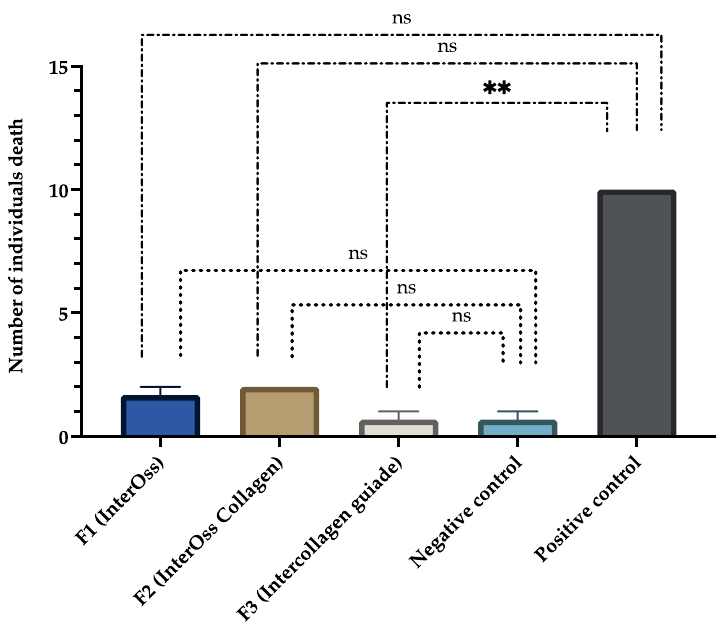
Figure 6. Number of individuals death for A. salina at after 48 h. (ns: non-significant differences between treatments and assays; ** p < 0.01).